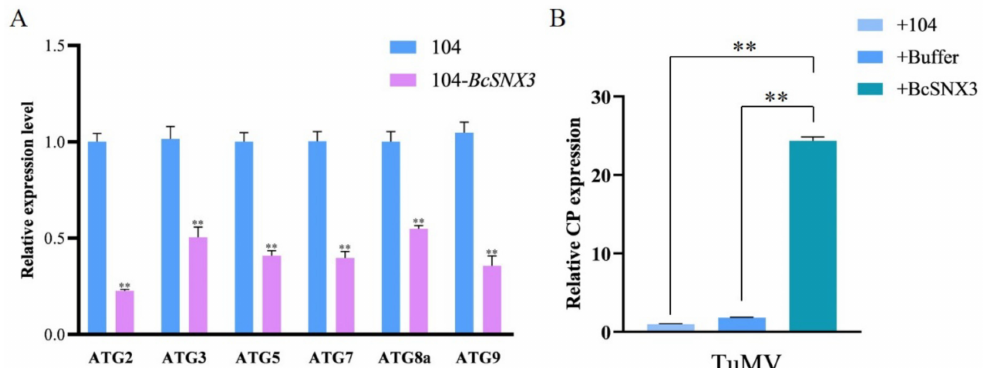
Figure 6. Overexpression of BcSNX3 inhibits the expression of autophagy components and promotes TuMV infection in N. benthamiana . ( A ) Effects of BcSNX3 overexpression on the expression of autophagy components at 3 days post-infiltration (dpi). N. benthamiana leaves were agroinfiltrated with 104 (empty vector) and 104- BcSNX3 (overexpress the BcSNX3 ). Total RNAs were extracted from infiltrated zones at 3 dpi. ( B ) RT-qPCR analysis of TuMV RNA accumulation in the inoculated leaves. Asterisks indicate significant differences, as determined by ANOVA-LSD (** p <